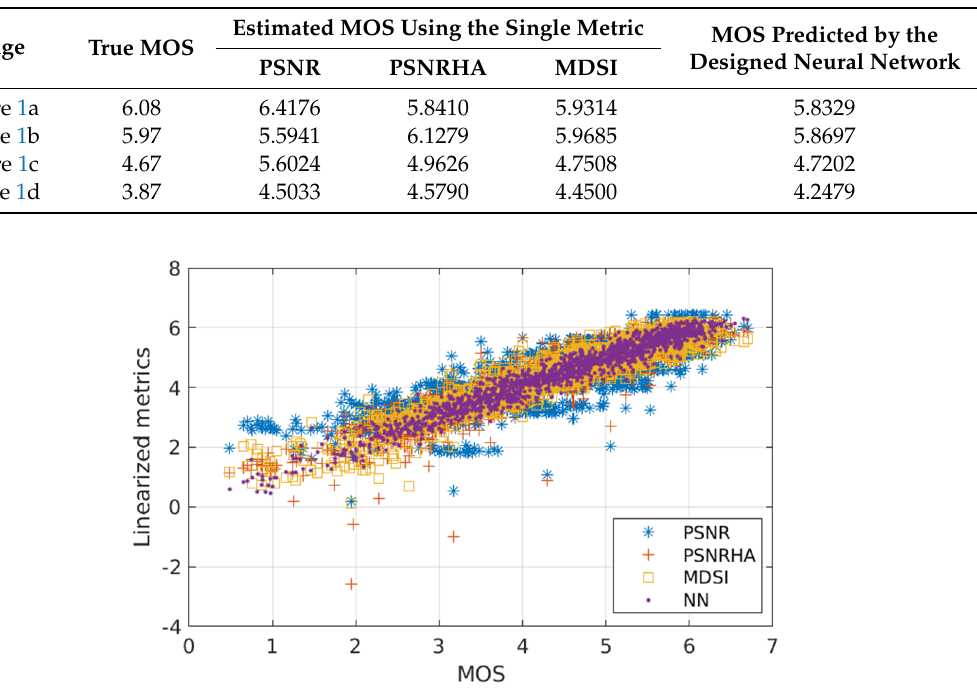
Figure 8. Scatter plot illustrating the correlation of the four methods of MOS prediction presented in Table 8 with true MOS values (range 0–7) for the TID2013 Noise&Actual subset.